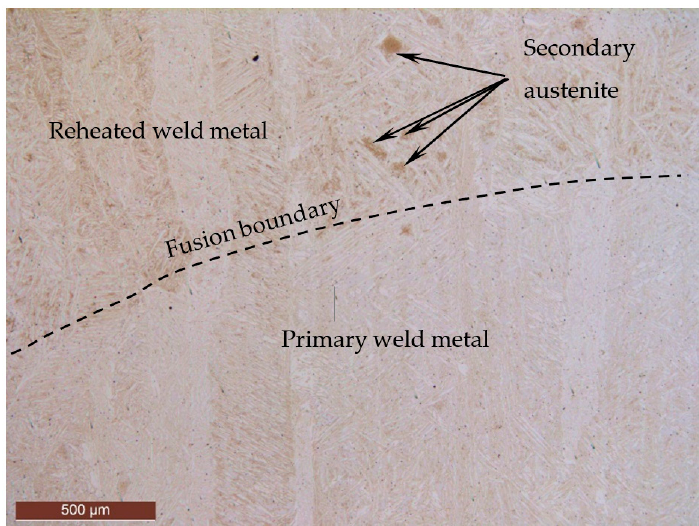
Figure 6. Epitaxial solidification in Wall 1.